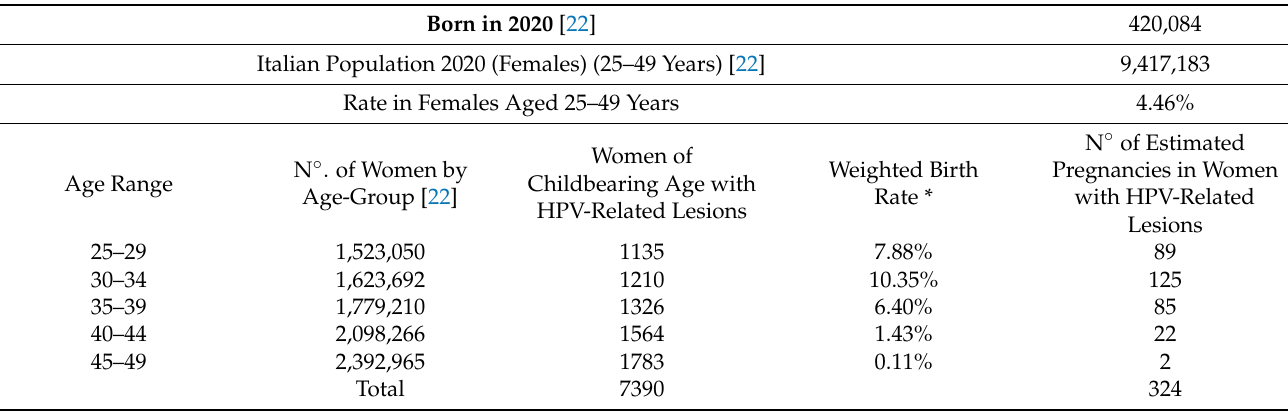
Table 6. The number of estimated pregnancies in women with HPV-related lesions, by age group.